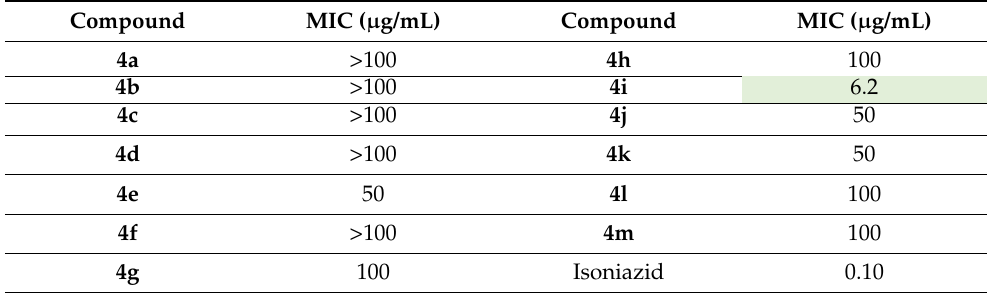
Table 2. Activity of compounds 4a–m against Mycobacterium tuberculosis H37Rv drug-sensitive strain. The most active compound ( 4i ) is marked green.